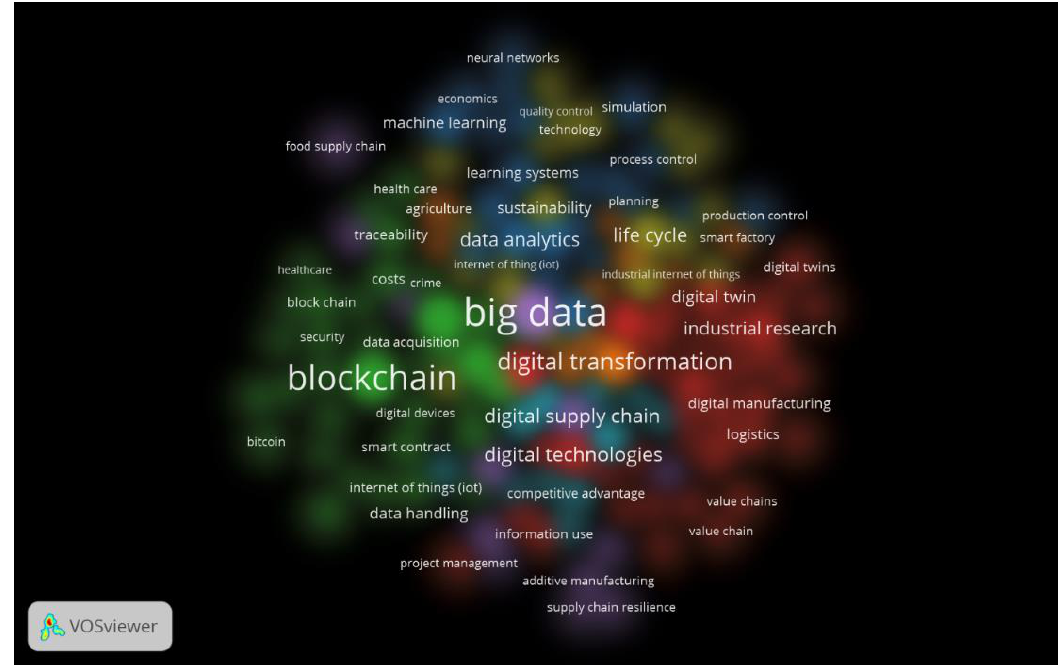
Figure 11. Keyword overlay visualization by VOS viewer software.